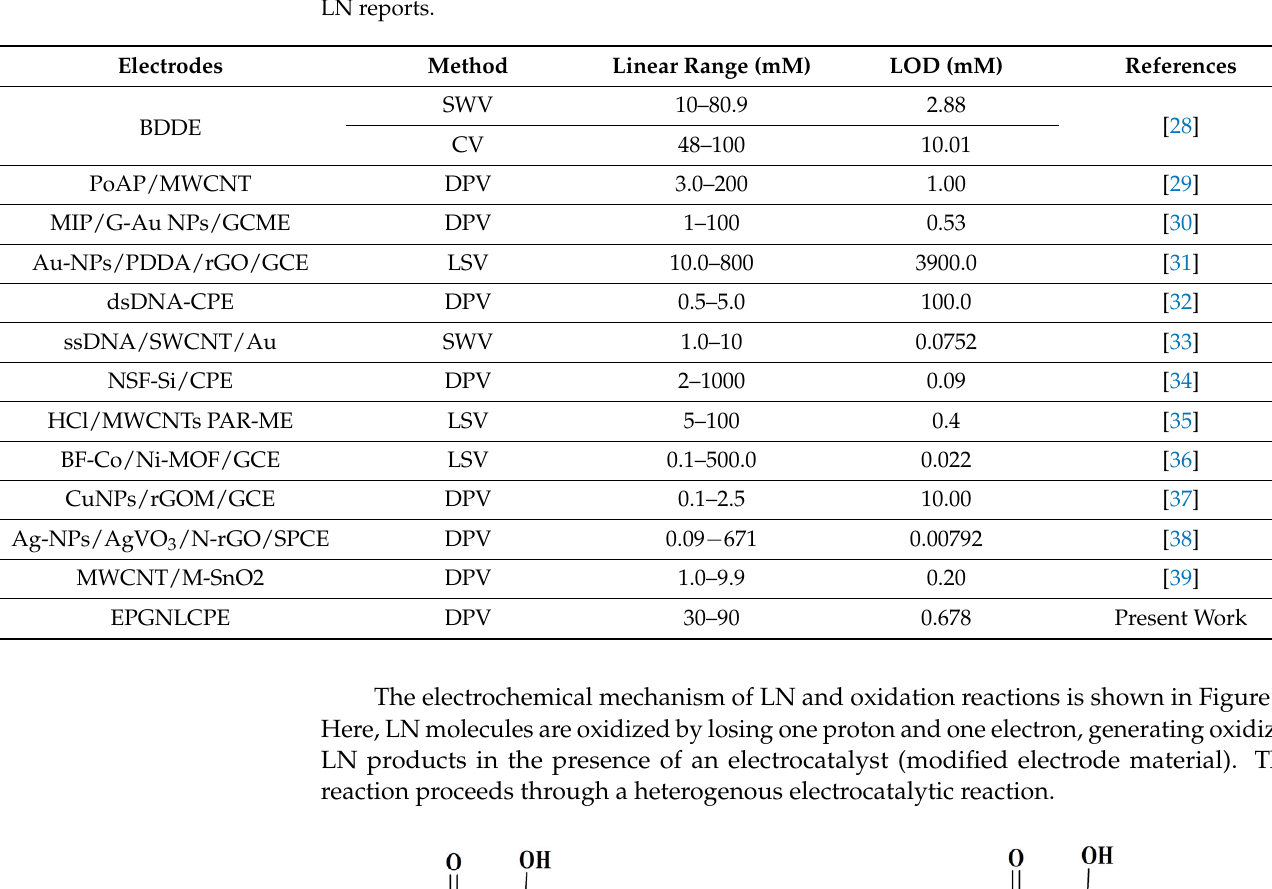
Table 1. Comparisons of present LOD of LN in different electrodes, and methods used in previous LN reports.